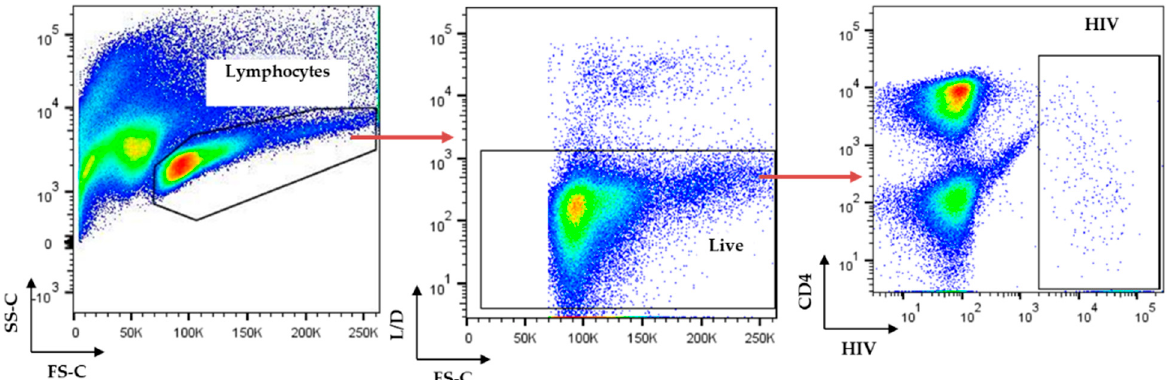
Figure 3. Flow cytometry gating strategy to assess the frequency of HIV-1 infected primary CD4 +